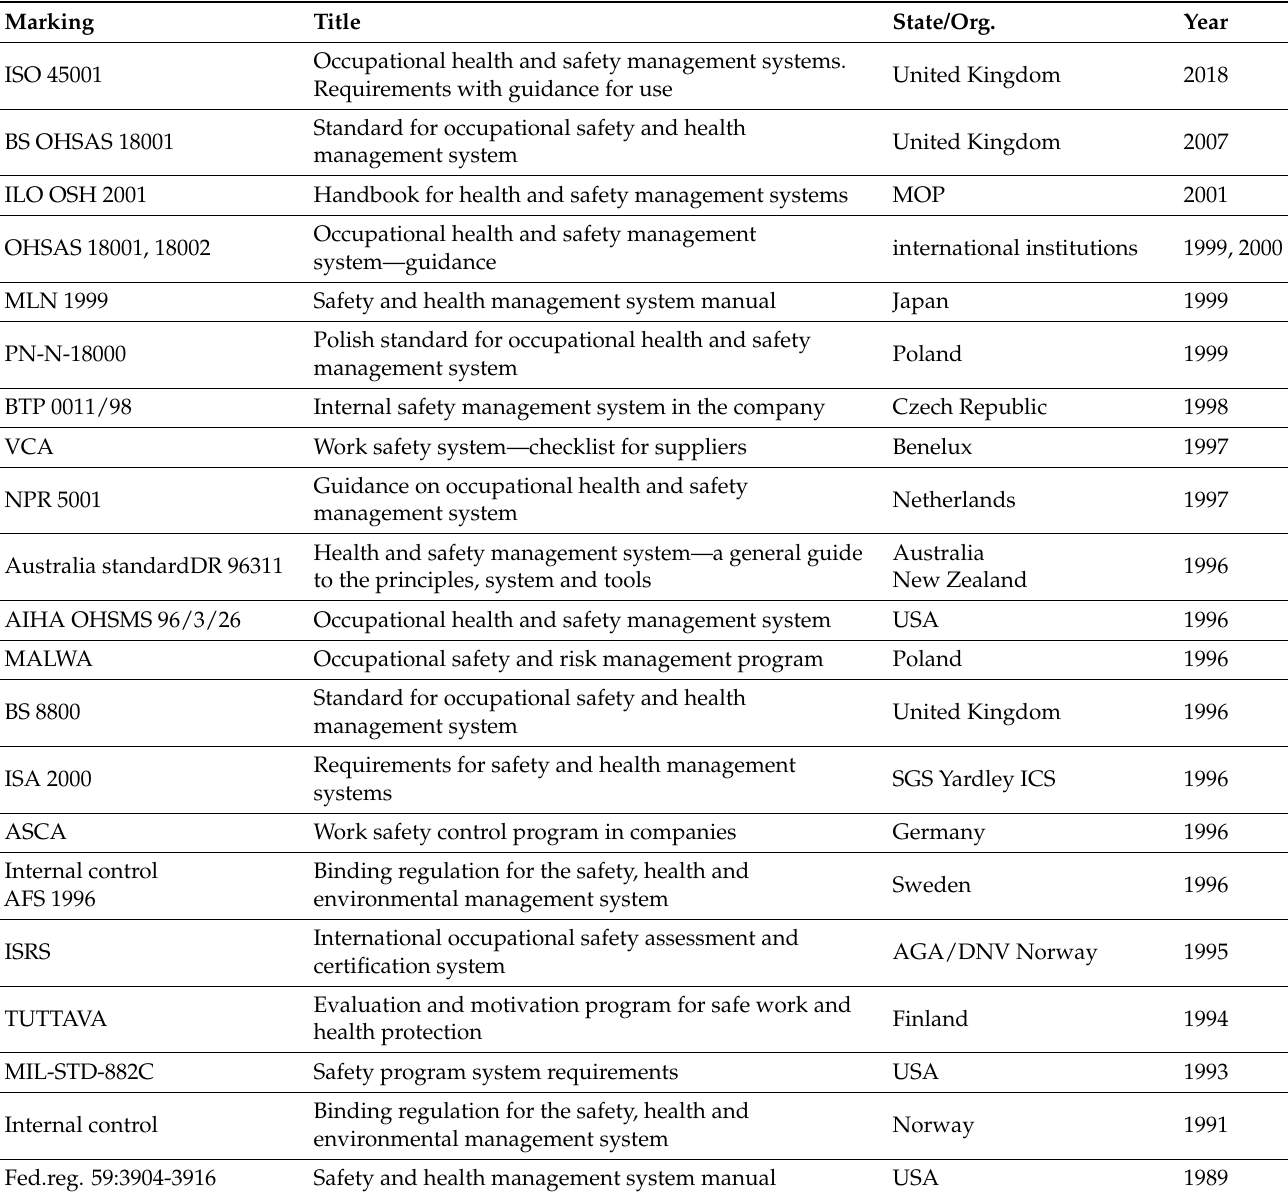
Table 1. An overview of some occupational health and safety management systems